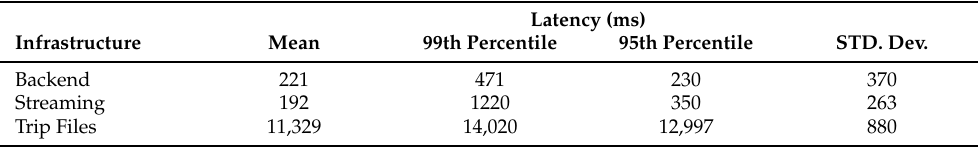
Table 5. The latency of the individual infrastructures during the